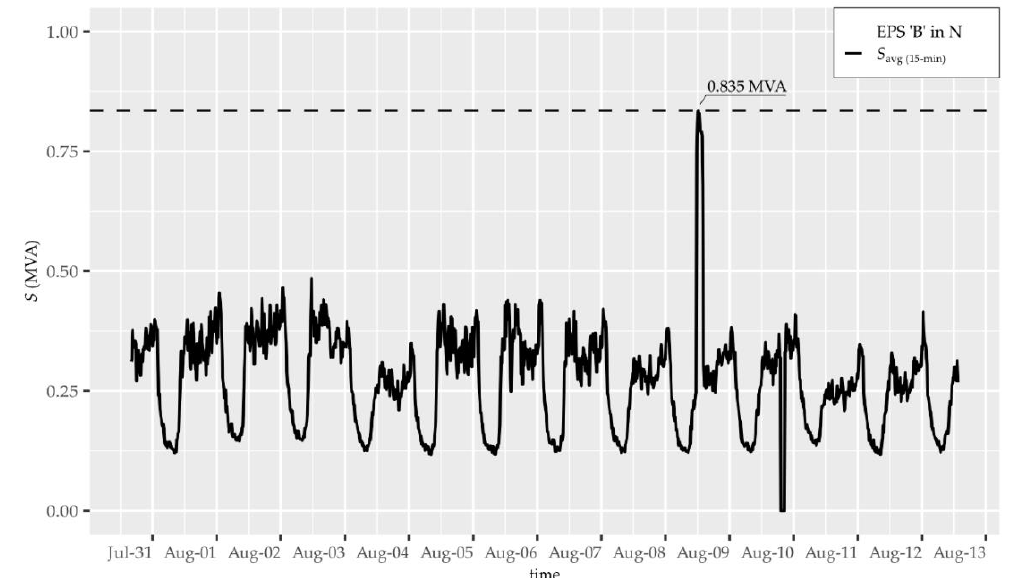
Figure 10. The S EPS “B” profile of the EPS “B” substation in the normal operating condition N. Figure 11 shows the 2-week power flow S of the considered substation EPS “A” in the operation condition N.